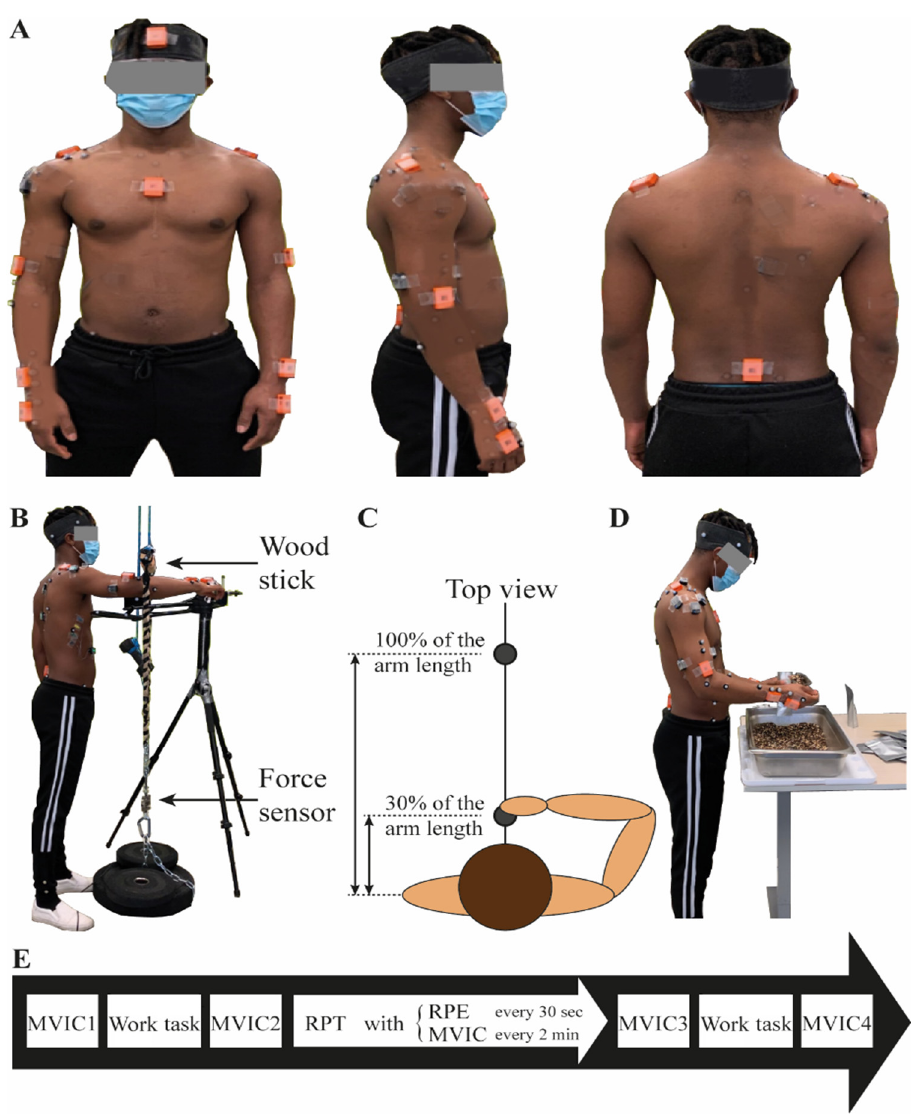
Figure 1. ( A ) Participant equipped with IMUs. ( B ) Picture of the MVIC setup. ( C ) Schematic top view of the RPT. ( D ) Work task. ( E ) Timeline of the experiment.